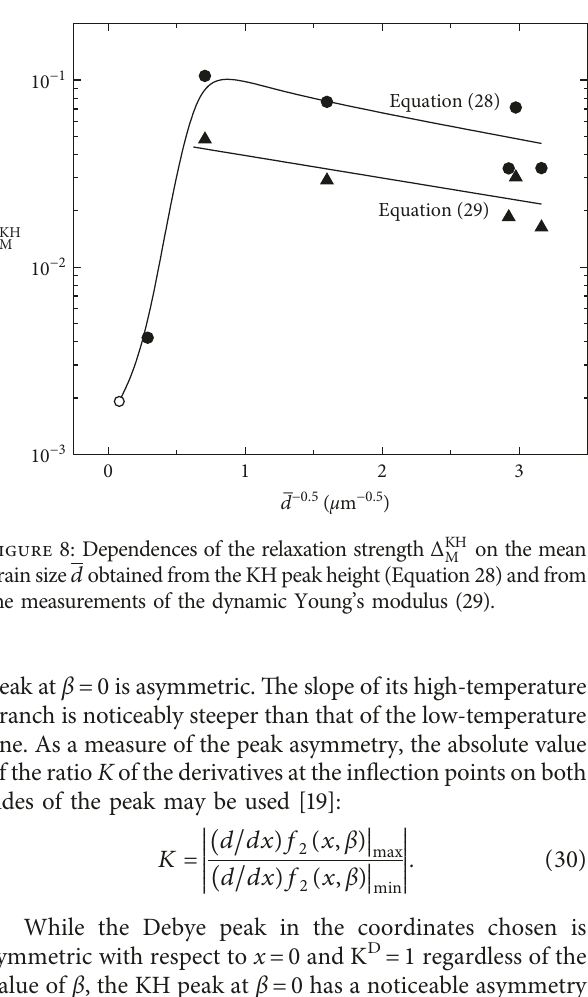
Figure 8: Dependences of the relaxation strength grain size d obtained from the KH peak height (Equation 28) and from the measurements of the dynamic Young’s modulus